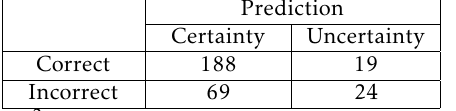
Table 1. Prediction accuracy of 3 statements using set ( Y at 450 msec. (Accuracy=70.7%)